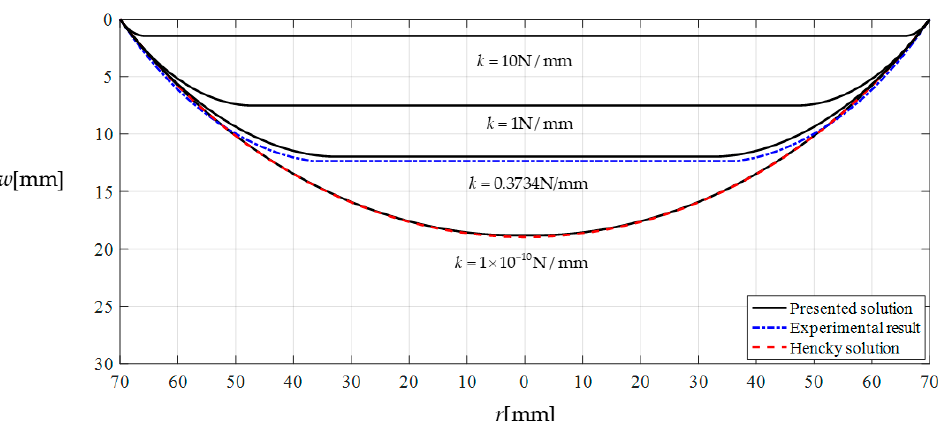
Figure 6. Variations of w with r when k takes 10 N / mm, 1 N / mm, 0.3734 N / mm and 1 × 10 − 10 N / mm, respectively, where q keeps 1086.80 Pa.